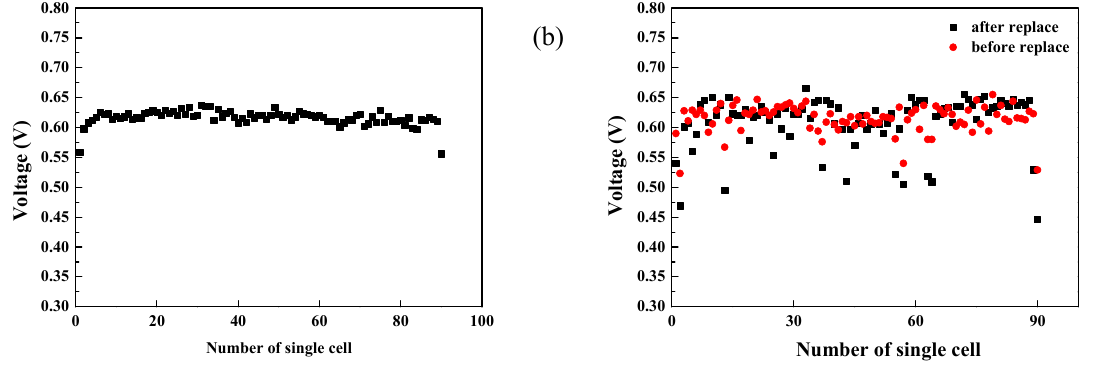
Figure 5. The cell voltage of a normal PEMFC stack with high consistency ( a ) and the cell voltage of a PEMFC stack before and after replacing specific cells ( b ).